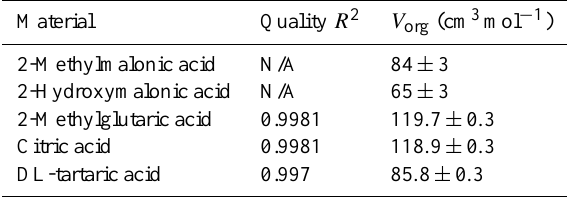
Table 1. Partial molar volumes of compounds under study. The “Quality R 2 ” column refers to the correlation coefficient of a fit of Eq. (3) using the stated V org to experimental data.